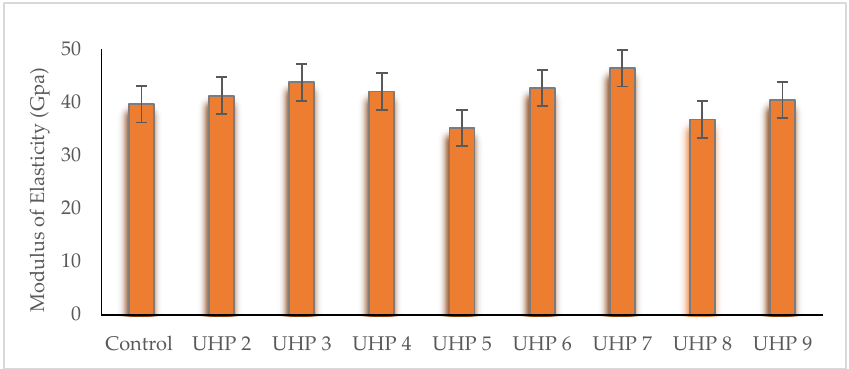
Figure 7. Modulus of elasticity after 90 days for glass and lime powder replacement ratios.